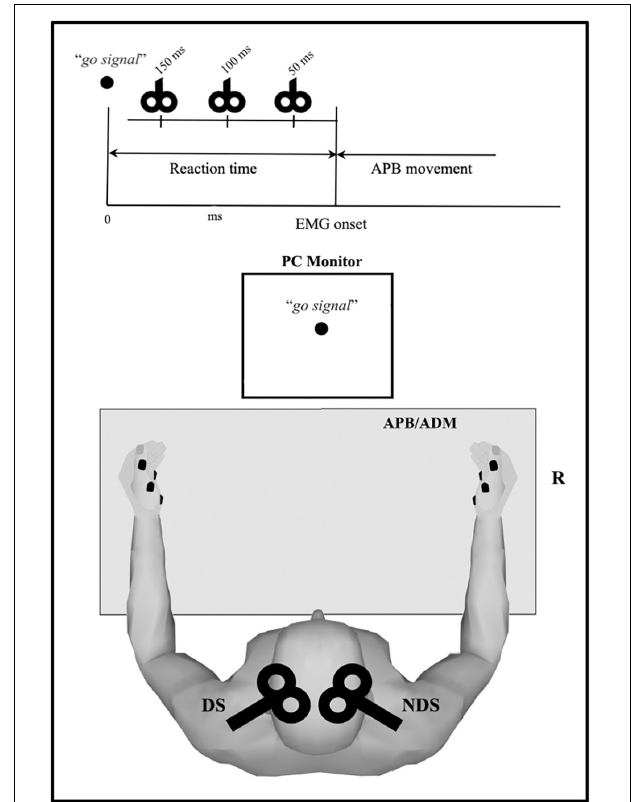
FIGURE 1 | Overview of the reaction time (RT) protocol. Motor task consists of rapid thumb abduction; transcranial magnetic stimulation (TMS) was delivered after the visual “go signal” and before the electromyography (EMG) onset (i.e., within the RT) at three intervals (50, 100, and 150 ms). Motor evoked potential were recorded from APB and ADM, bilaterally. APB, abductor pollicis brevis; ADM, abductor digiti